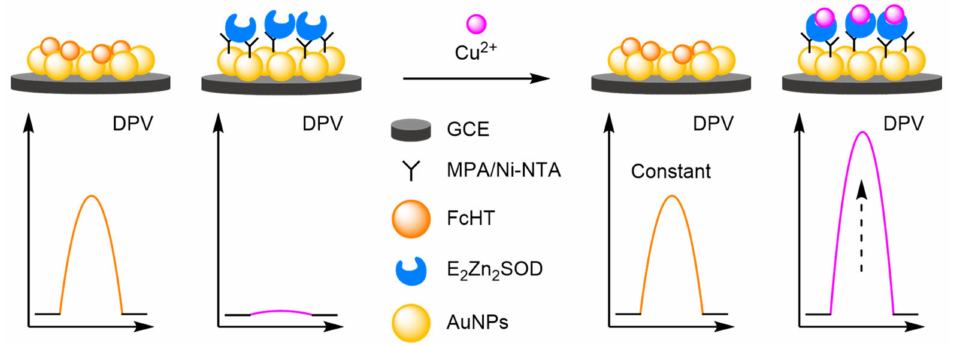
Figure 50. Schematic representation of a dual-channel biosensor for the detection of Cu 2+ .